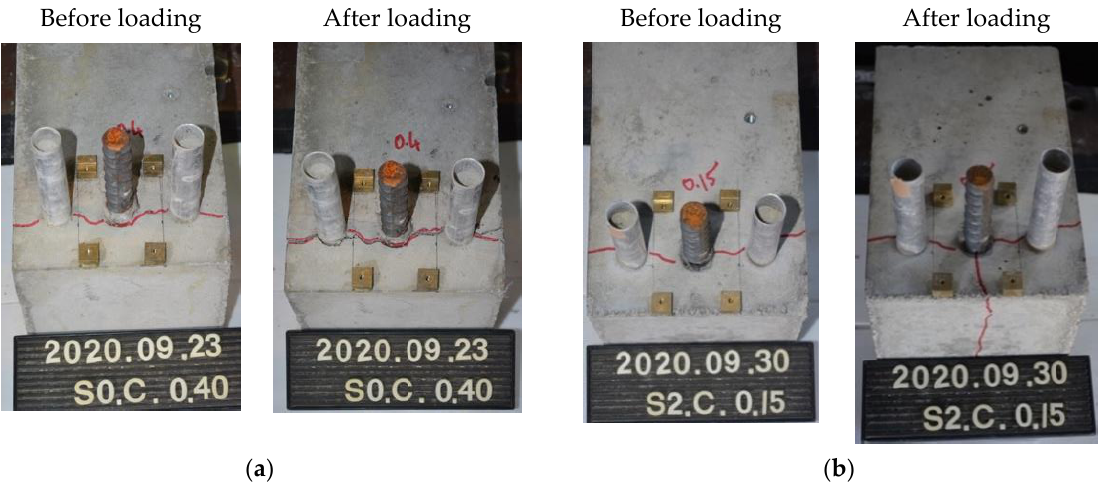
Figure 10. Failure mode: ( a ) side split failure ; ( b ) face split failure.